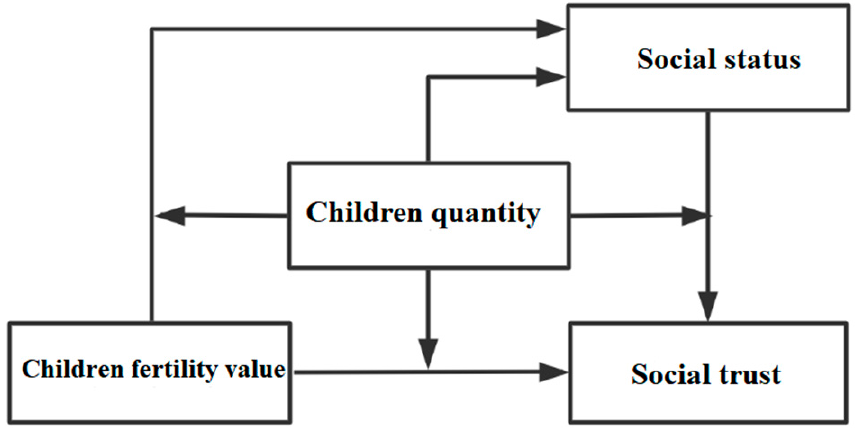
Figure 4. Children quantity–social status mixed moderation mediating effect model of fertility influencing social trust .